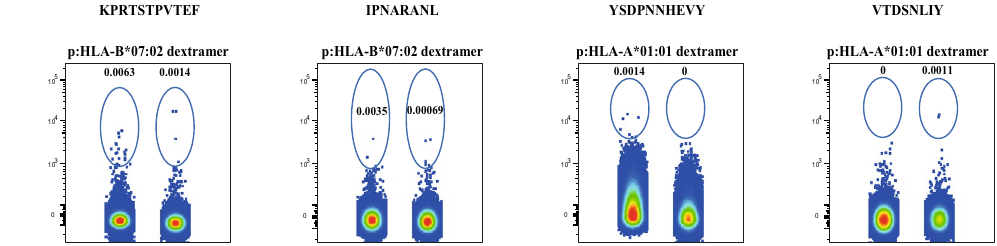
Figure 3. Detection of epitope-specific T cells from recently vaccinated young adults (A) Flow cytometric ex vivo detection of epitope-specific T cells using p:HLA-class I dextramers from PBMC samples of two HLA- B7-positive (#IIV-291-034 (left datasets of first 3 plots) and VAC-076 (right datasets of first 3 plots) to detect responses to three HLA-B*07:02-restricted epitopes, and to detect responses to two